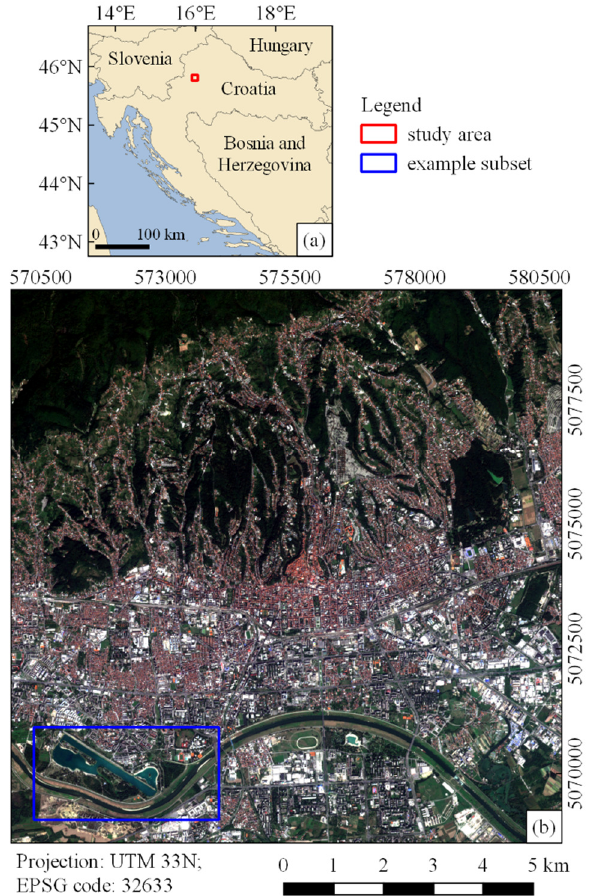
Figure 1. (a) Location of the study area, (b) study area and